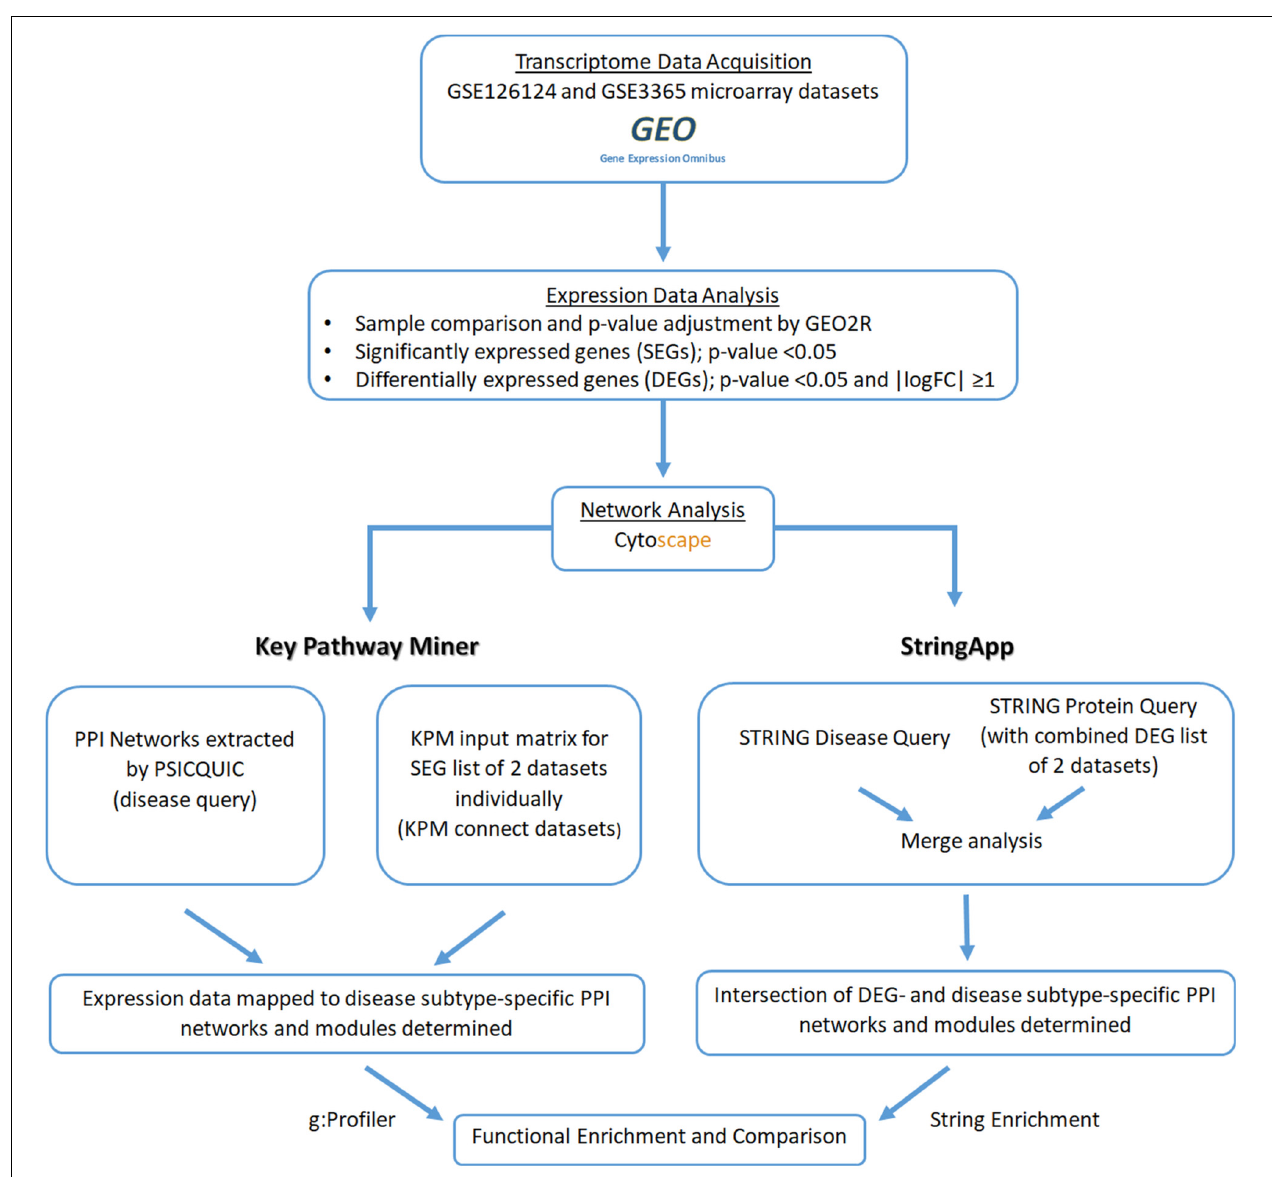
FIGURE 1 | Workflow of the comprehensive protein–protein interaction (PPI) network analysis by mapping transcriptome data for the discovery of ulcerative colitis (UC)- and Crohn’s disease (CD)-specific